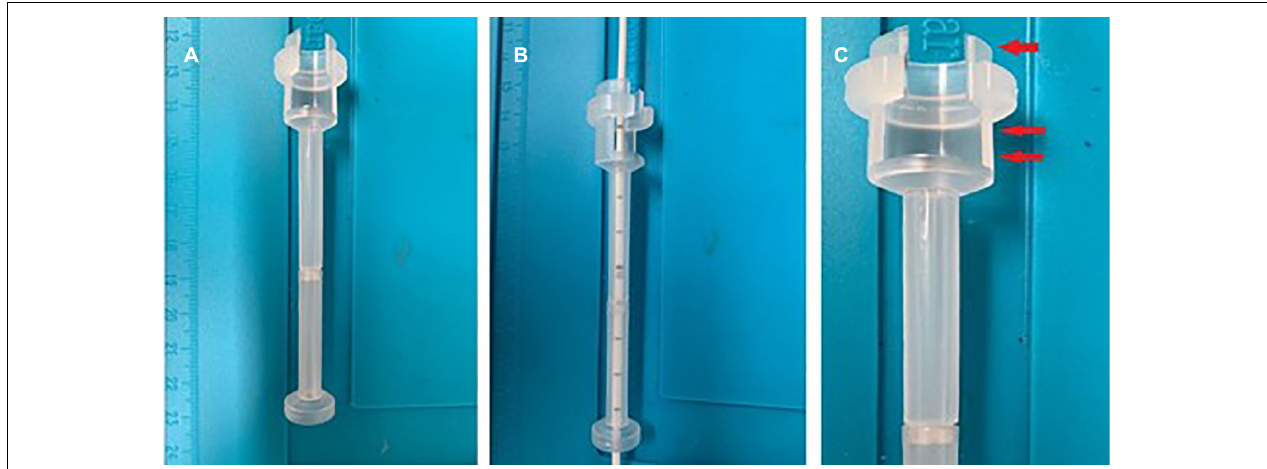
FIGURE 3 | The device is semitransparent, allowing catheter control during insertion (A,B) . The catheter’s proximal end (arrow), which helps to fix the device to the skull with the correct trajectory. The proximal end also presents a window to clamp the catheter before removing the mandrel (double arrows) (C)